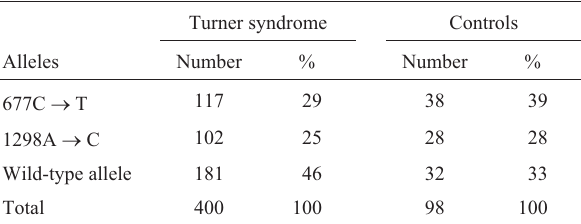
Figure 2 - Polymorphism analysis of the methylenetetrahydrofolate reductase (MTHFR) of the 1298A (cid:1) C allele: MboI I-digested PCR frag- ments from the 1298A (cid:1) C mutation (84 and 31/30 bp) and from the nor- mal allele (56, 31/30 and 28 bp). M = molecular weight marker; 1 = undigested control fragment; 2 = control without the polymorphism; 3, 4 and 5 = 1298A (cid:1) C heterozygous Turner syndrome (TS) individuals; 6 and9 = (cid:1) ChomozygousTSindividual;7and8=1298A (cid:1) CnullTSin- Table 1 - Frequencies of the methylenetetrahydrofolate reductase (MTHFR) 677C (cid:1) T and 1298A (cid:1) C alleles in 49 individuals with Turner syndrome and 200 controls.